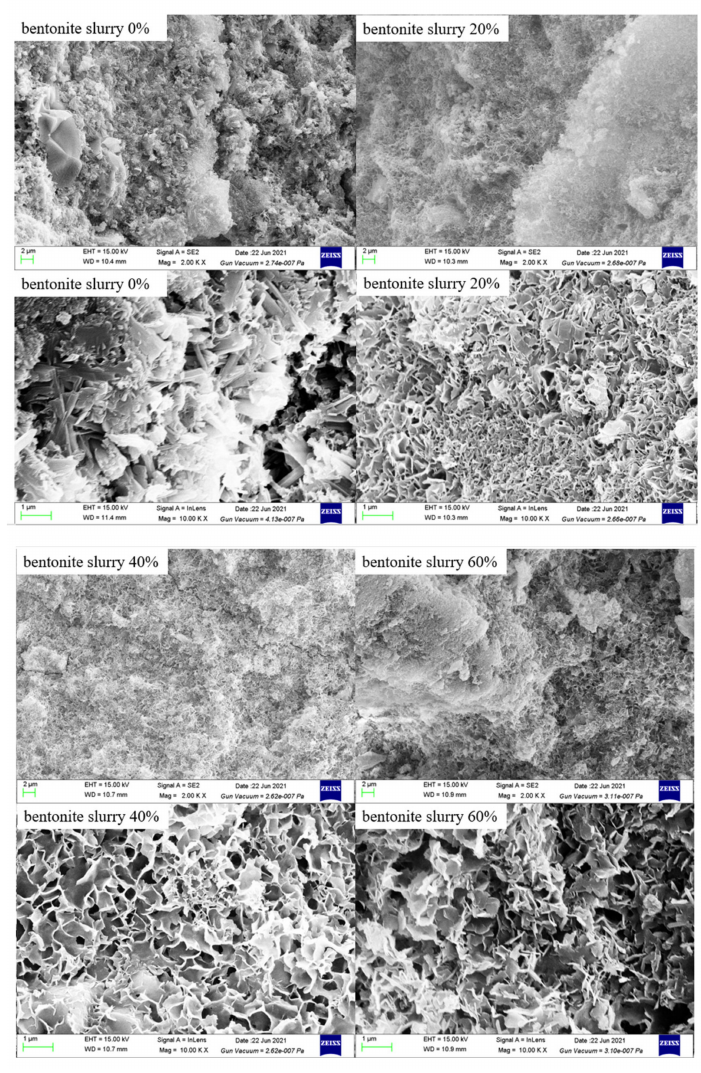
Figure 8. SEM images of porous samples and